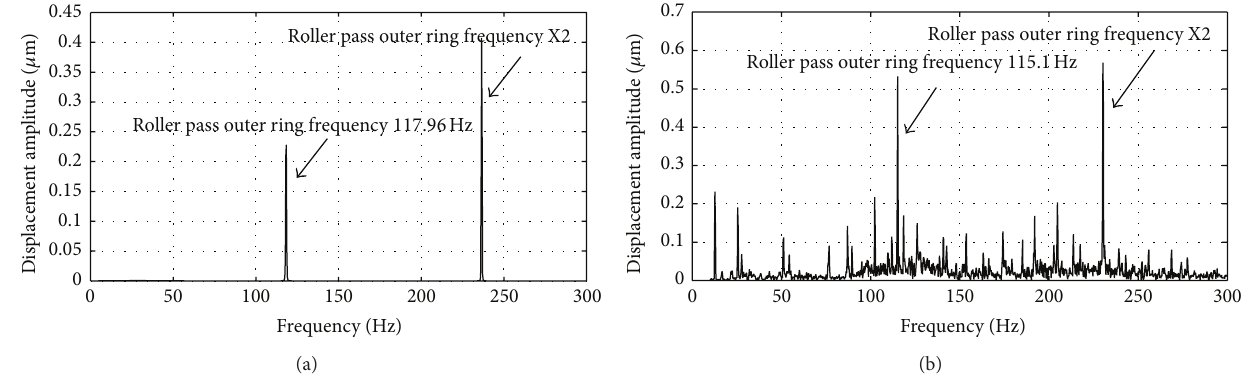
Figure 18: Vertical displacement amplitude for outer ring defect: (a) simulation; (b) measurement data.